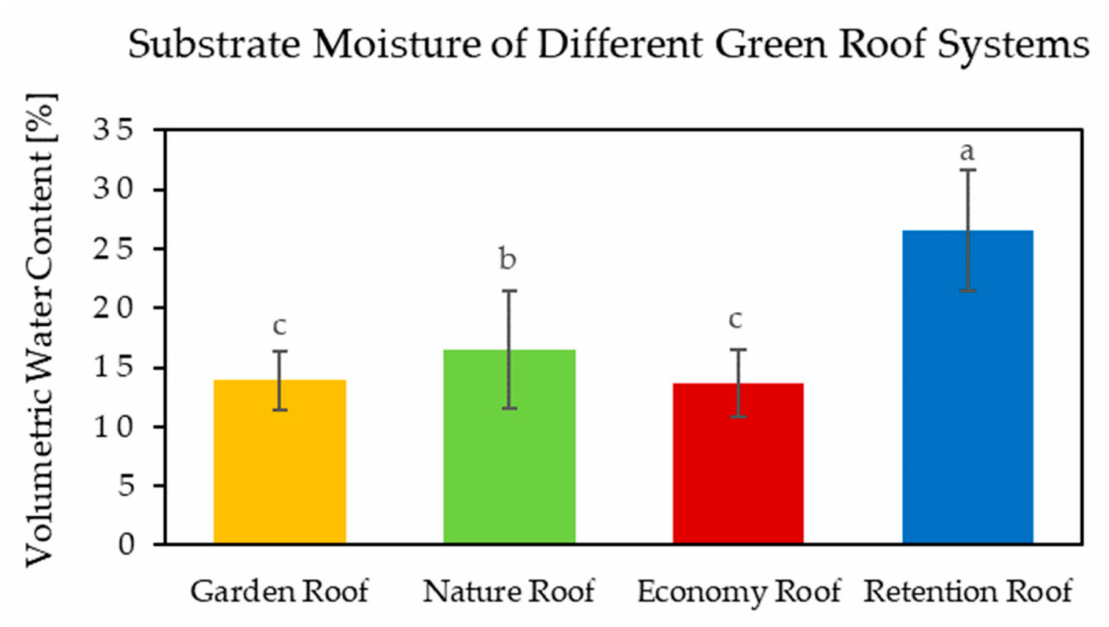
Figure 6. Average substrate moisture of the four different green roofs with means ± SD (n = 204 for Garden Roof ; n = 205 for other roofs). Different letters above the whiskers indicate significant differences between means (Friedman Test p <